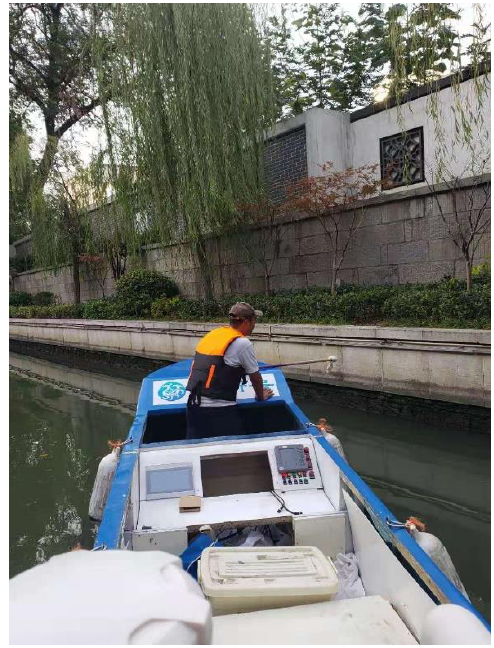
Figure 1. A potential accident of the model MASS trial in Qinhuai River (Source: The first author).